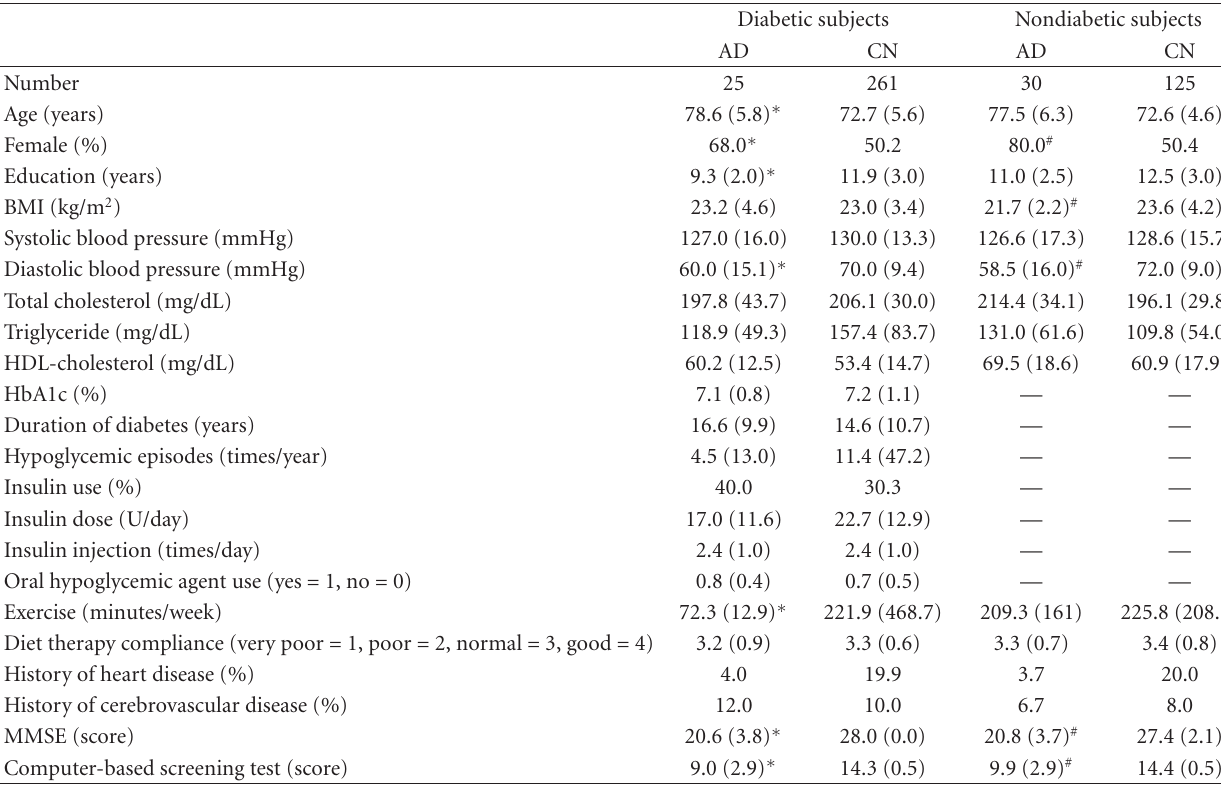
Table 1: Demographic and clinical profile of study participants.